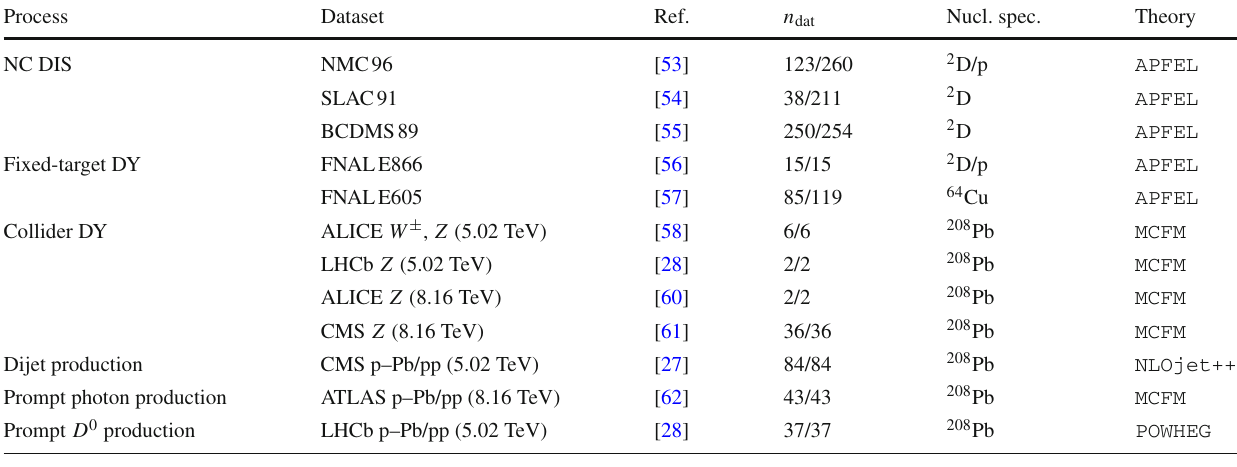
Table 1 The new measurements included in nNNPDF3.0 with respect to nNNPDF2.0. For each dataset, we indicate the name used through- out the paper, the reference, the number of data points n dat after/before kinematic cuts, the nuclear species involved, and the codes used to com-